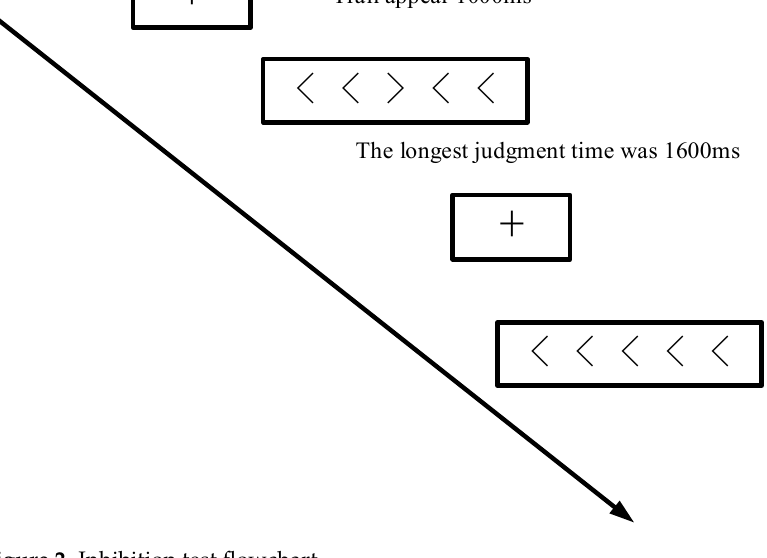
Figure 2. Inhibition test flowchart.